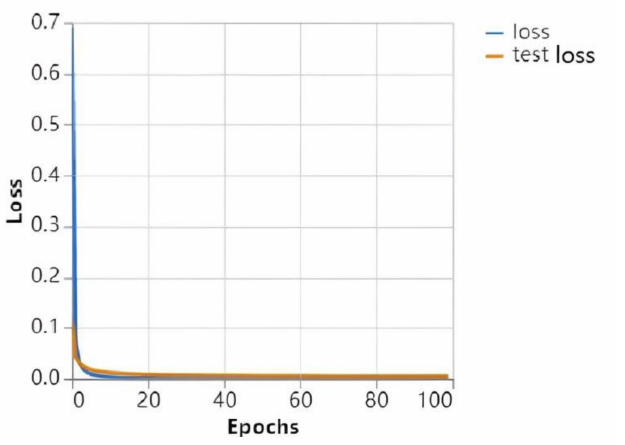
Figure 7. Loss function curves for training and test sets of the YOLOv5 network. The x-axis and the y-axis represent the epochs experienced and the loss function value, respectively. The loss function value converges rapidly as the epoch grows.